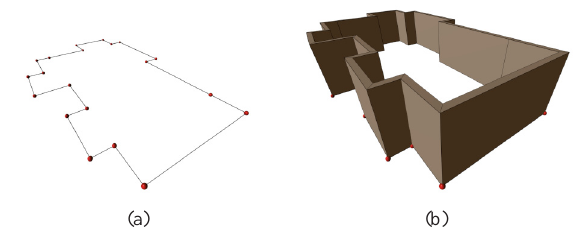
Figure 9: Wall construction . Given a simple polygon as outer boundary (a), one wall piece is constructed for each polygon seg- ment (b) by making use of the offset polygon.